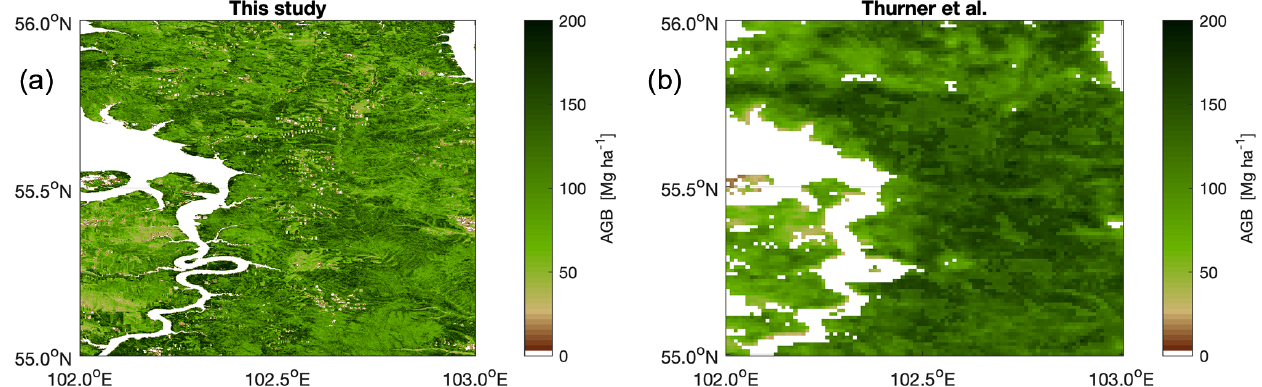
Figure 3. AGB estimates from this study (left) and from Thurner et al. (2014) for a 1 ◦ × 1 ◦ area in central Siberia.